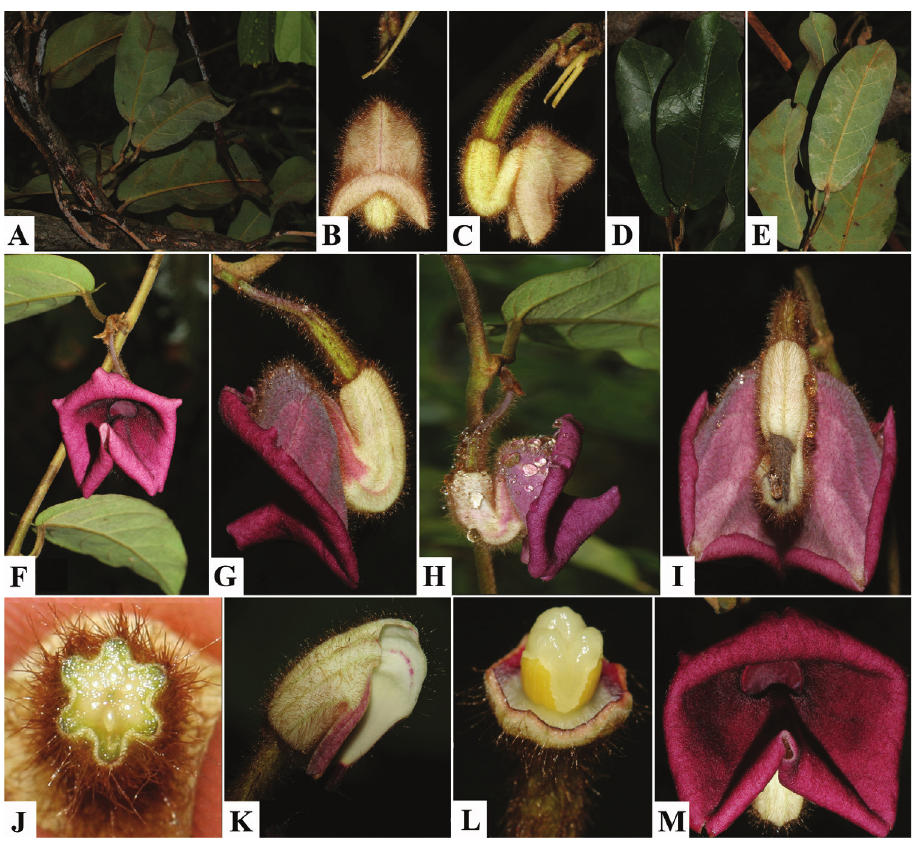
Figure 2. Photographs of Aristolochia quangbinhensis T.V. Do. A Habit B–C Frontal ( B ) and lateral ( C ) views of a preanthetic flower D–e Leaf in adaxial ( D ) and abaxial ( e ) views F Flowering branch G–I Lateral ( G–h ) and dorsal ( I ) views of flowers at anthesis J Transverse section of the ovary K Inner surface of peri- anth l Gynostemium and ovary M Frontal view of an anthetic flower. Photographs taken on the holotype locality in Hoa Luong community, Minh Hoa district, Quang Binh province, Central